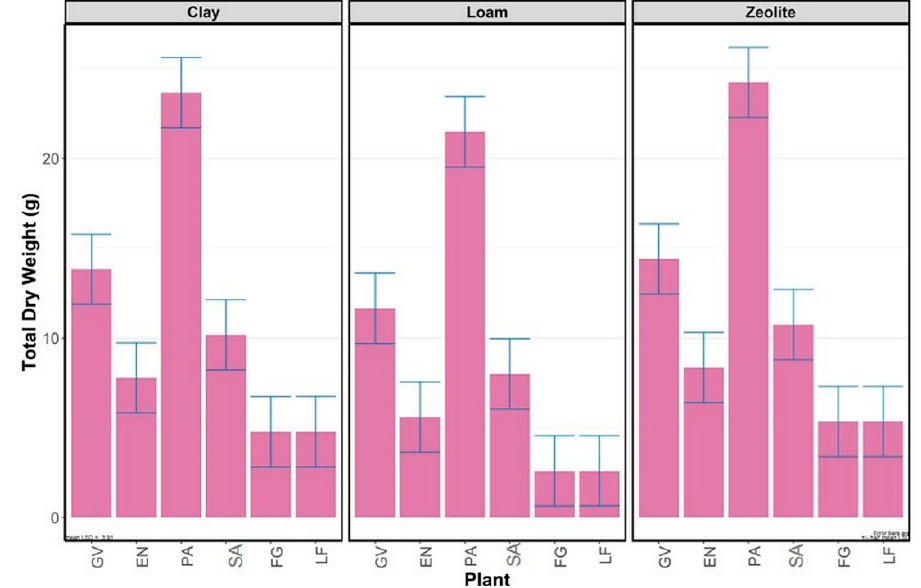
Figure 7. Predictions of dry weight for plants in different substrates. Error bars are approximately ±0.5 LSD (5%); if they do not overlap, the predicted means are significantly different ( p ≤ 0.05), while those whose error bars overlap are not significantly different ( p > 0.05).